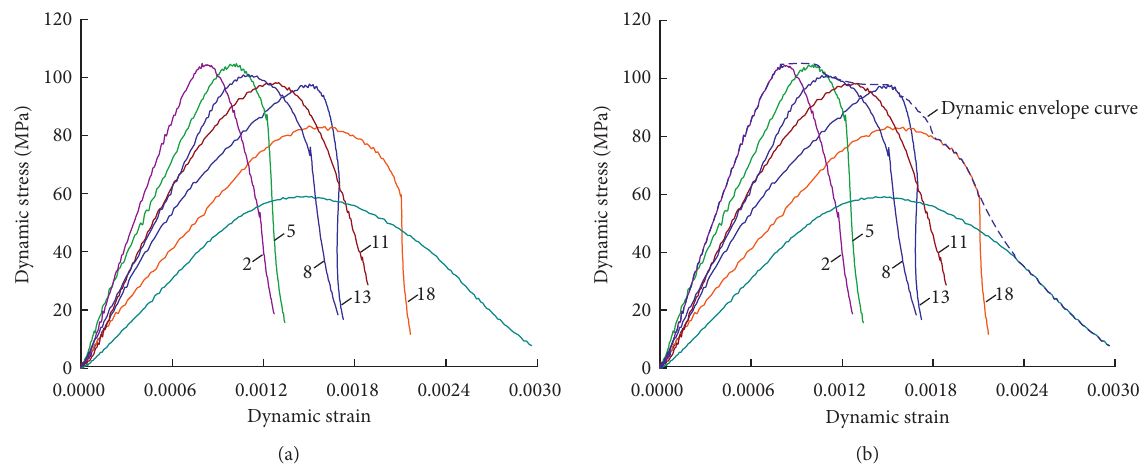
Figure 4: (a) Dynamic stress-strain curve and (b) envelope curve of skarn under the common action of high static stress unloading and impact disturbance (axial load 85MPa; unloading rate 1.0MPa/s).